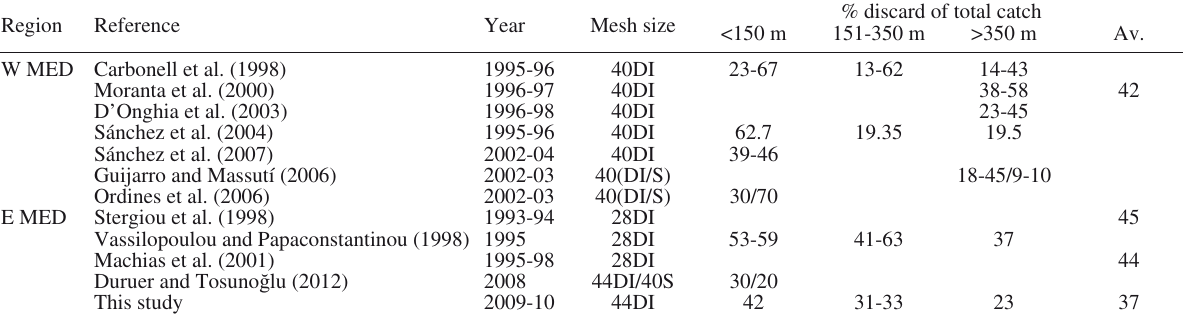
Table 5. – Summary of bibliographic information on the percentages of discarded catch produced by bottom trawl fisheries by depth stratum in different areas of the Mediterranean. S, square mesh; DI, diamond mesh; W MED, western Mediterranean; E MED, eastern Mediterranean.